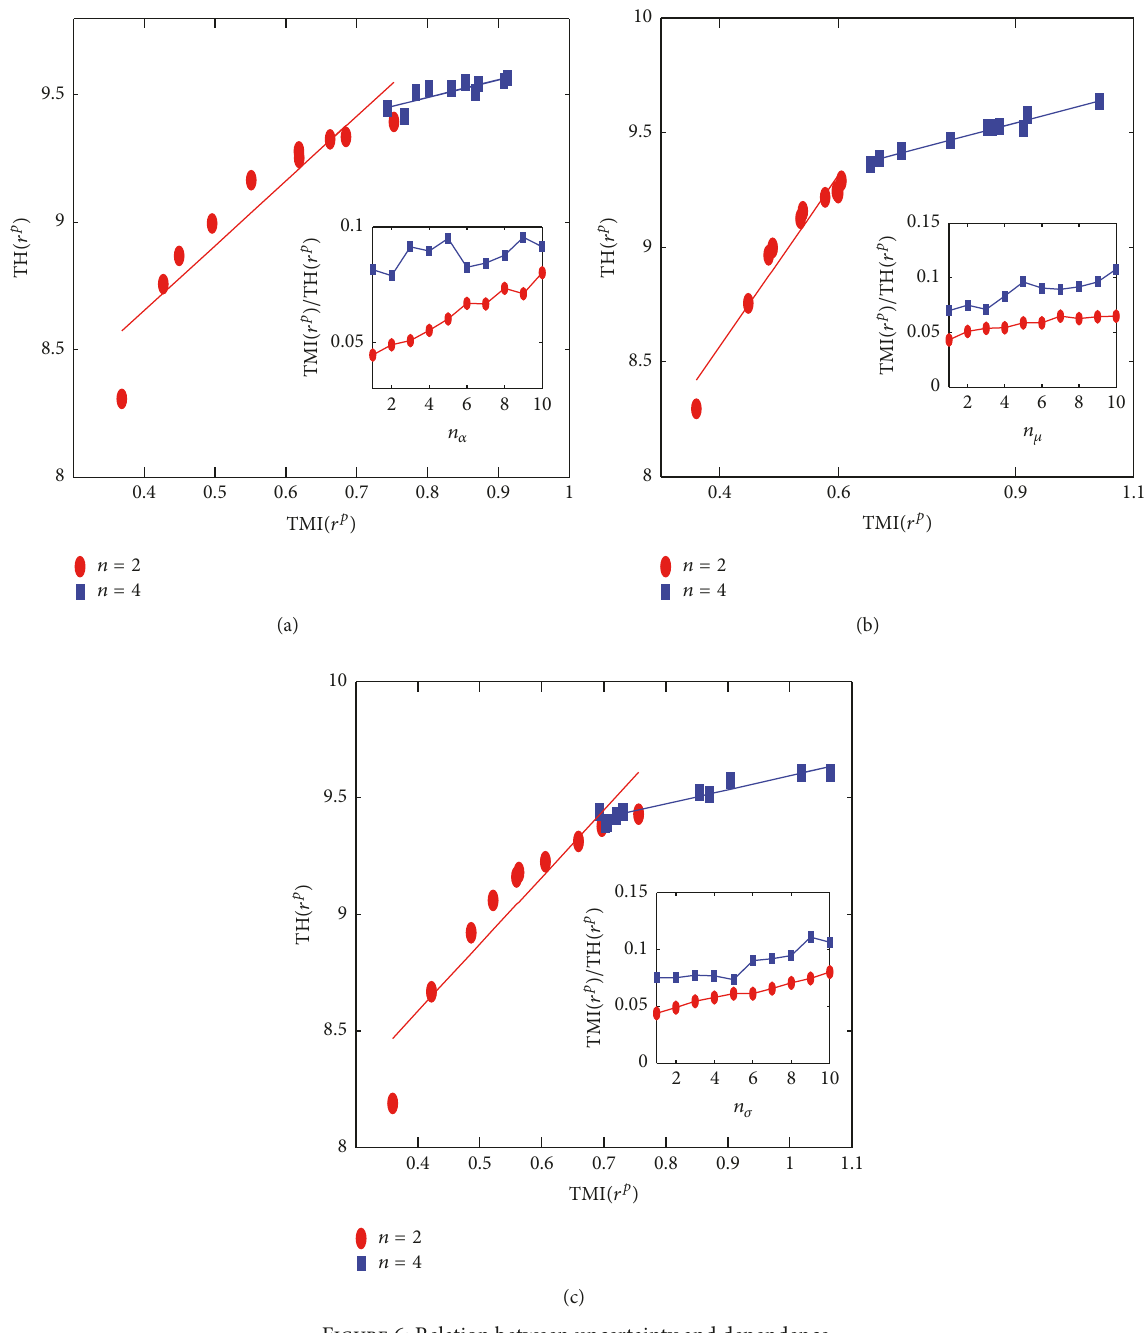
Figure 6: Relation between uncertainty and dependence.